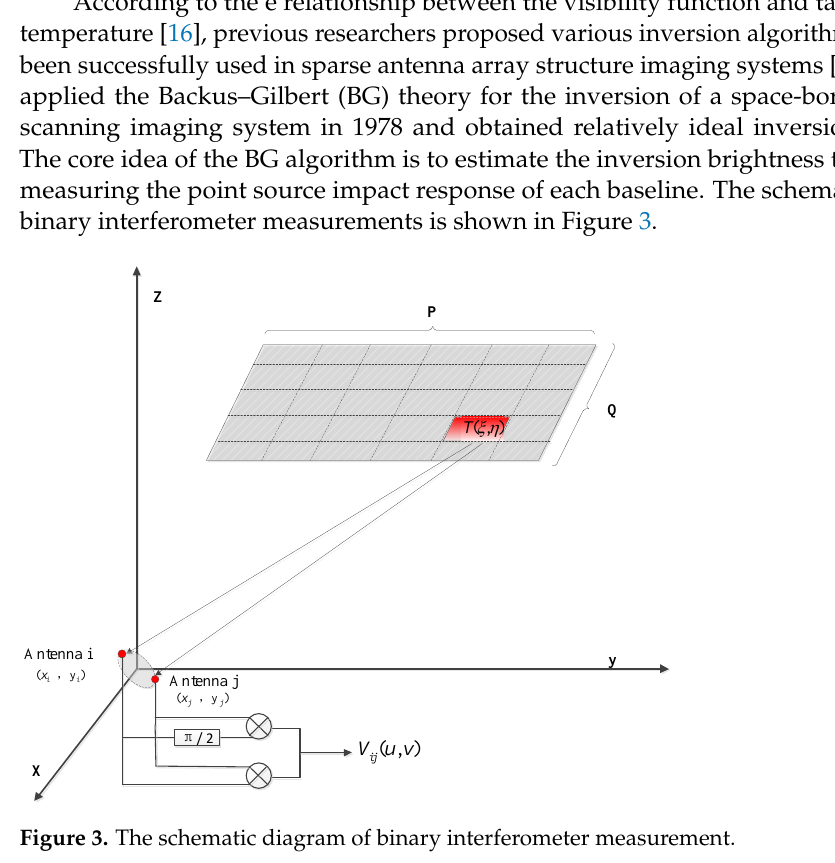
Figure 2. The arrangement of the antenna units and the U-V distribution diagram.